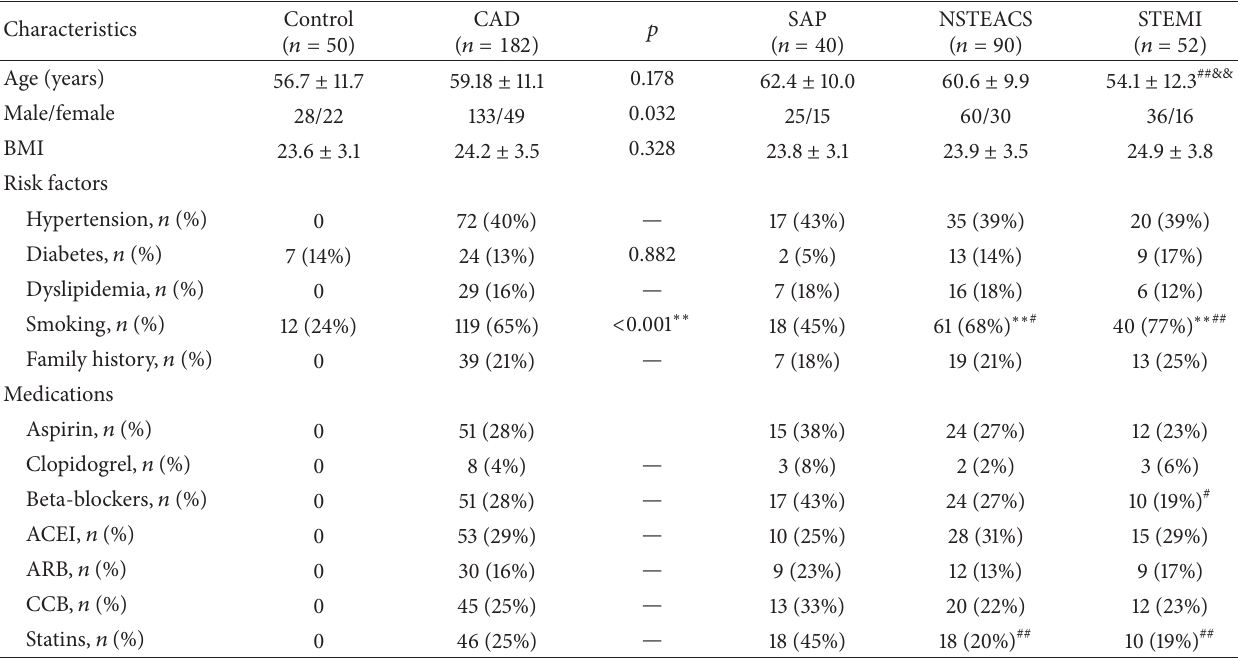
Table 1: Clinical characteristics of patients.